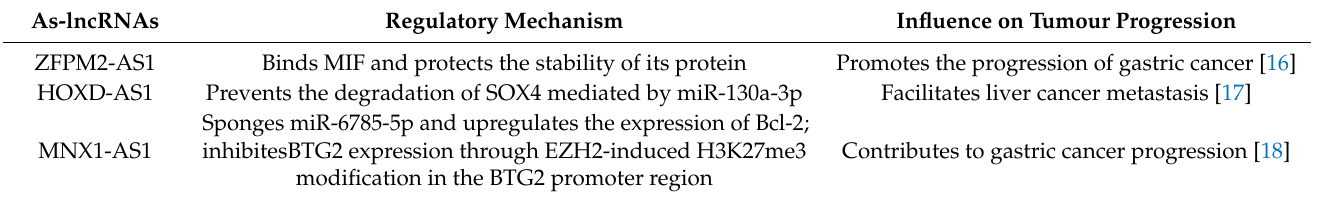
Table 1. Regulation of trans-acting as-lncRNAs on target genes and their effects on tumor